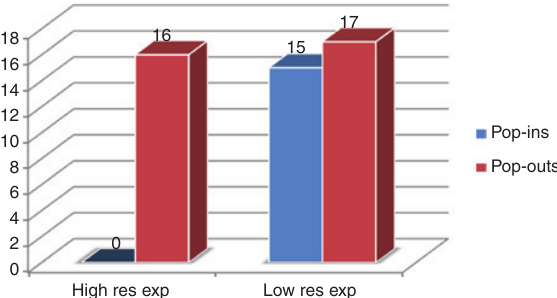
Figure 9: Bar chart of pop-ins/pop-outs in experiments with high (80 mN/min) and low (1 mN/min) indentation loading/unloading rate.